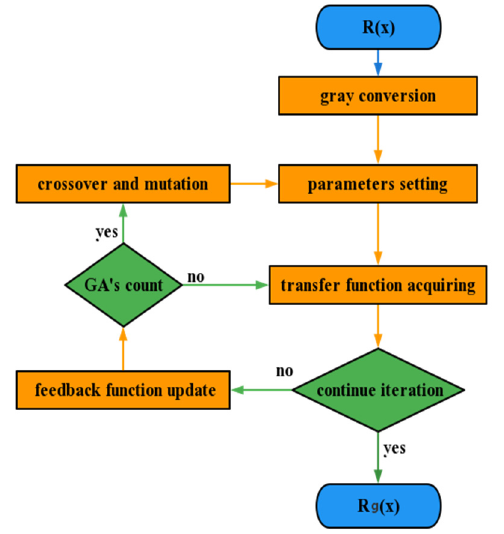
Figure 3. Transfer function optimization based on VGA.